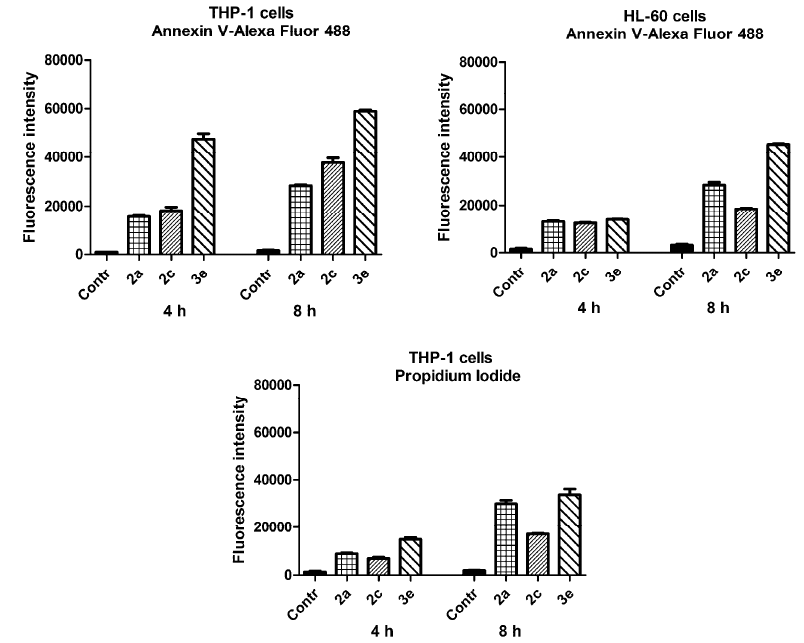
Figure 6. Apoptosis induction capacity of N -(phenothiazin-3-yl)-thioamides 2a , 2c , and TAPTZ 3e monitored by fluorescence emission measured at 530–575 nm (488 nm excitation) upon human monocytic leukaemia cell THP-1 and human promyelocytic leukaemia cell HL-60 populations stained with: Annexin V ( above ), propidium iodide ( below ).